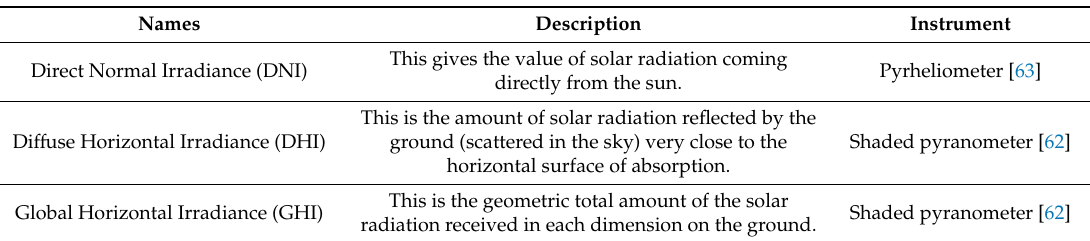
Table 1. Di ff erence between Direct Normal Irradiance (DNI), Di ff use Horizontal Irradiance (DHI), and Global Horizontal Irradiance